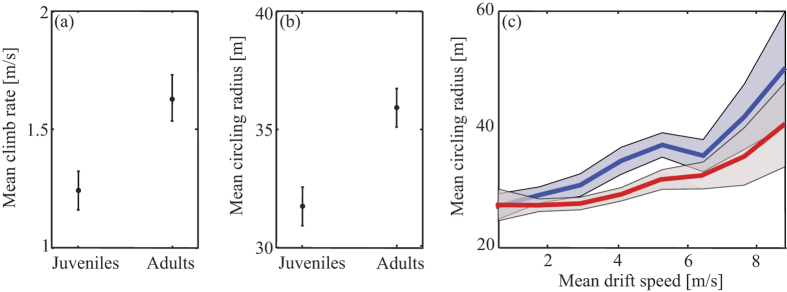
Age-related differences in thermal centering.(a) Climb rates in thermals of juvenile and adult vultures differed, with juveniles having lower climb rates (U = 85, P = 0.003). (b) The circling radius of juveniles was smaller (U = 79, P = 0.02). (c) No age-related differences in circling radii under low wind shear conditions were observed, but greater circling radii were found for adults (blue) compared with juveniles (red) under intermediate wind shear conditions. Grayish areas indicate SE. Values in panels a and b are mean ± SE.